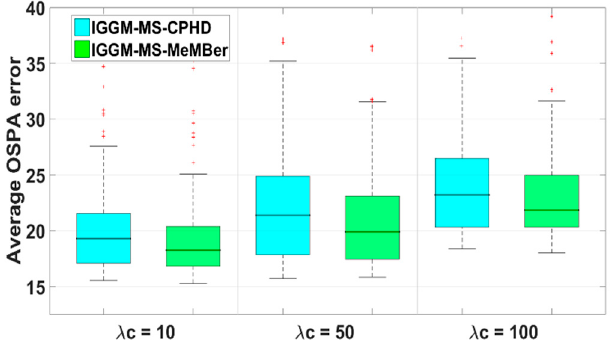
Figure 6. OSPA distances for different clutter intensities.